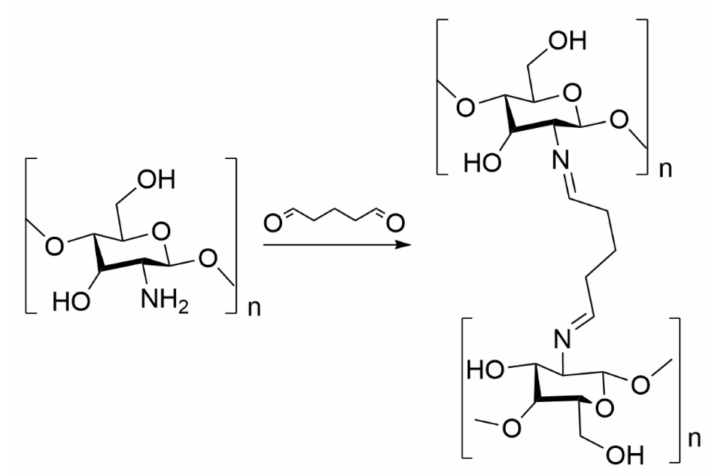
Figure 2. Cross-linking chitosan with